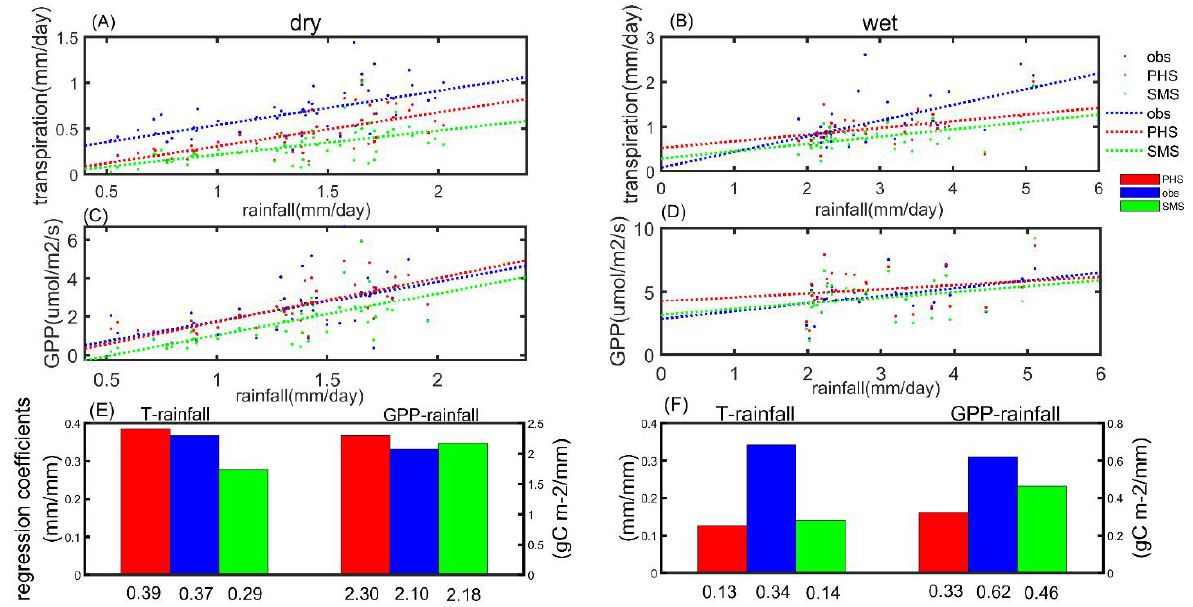
Figure 10. Drought sensitivity of transpiration and GPP. ( A , B ) are unary regression between T and precipitation. ( C , D ) are unary regression between GPP and precipitation. ( E , F ) are regression coefficients. The figures in the right column are the results from the dry sites, and the figures from the left column are the results from the wet sites.